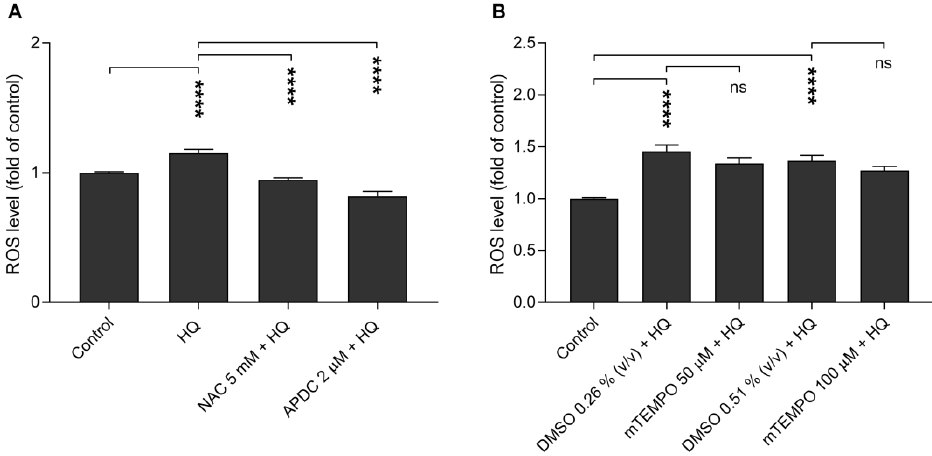
Figure 6. The ability of antioxidants N-acetyl-cysteine (NAC), aminopyrrolidine-2,4-dicarboxylic acid (APDC) ( A ) and mitochondrial-targeted superoxide dismutase (SOD) mimetic (mTEMPO; 50 µ M, DMSO 0.26% v / v ; 100 µ M, DMSO 0.51% v / v ) ( B ) to prevent hydroquinone (HQ)-induced ROS production. ROS levels of untreated control cells were set to be 1 and other groups were compared to that. The results are combined from three independent experiments with six parallel samples per group in each experiment and shown as mean ± SEM. **** p < 0.0001, ns—not significant, Mann-Whitney U-test.